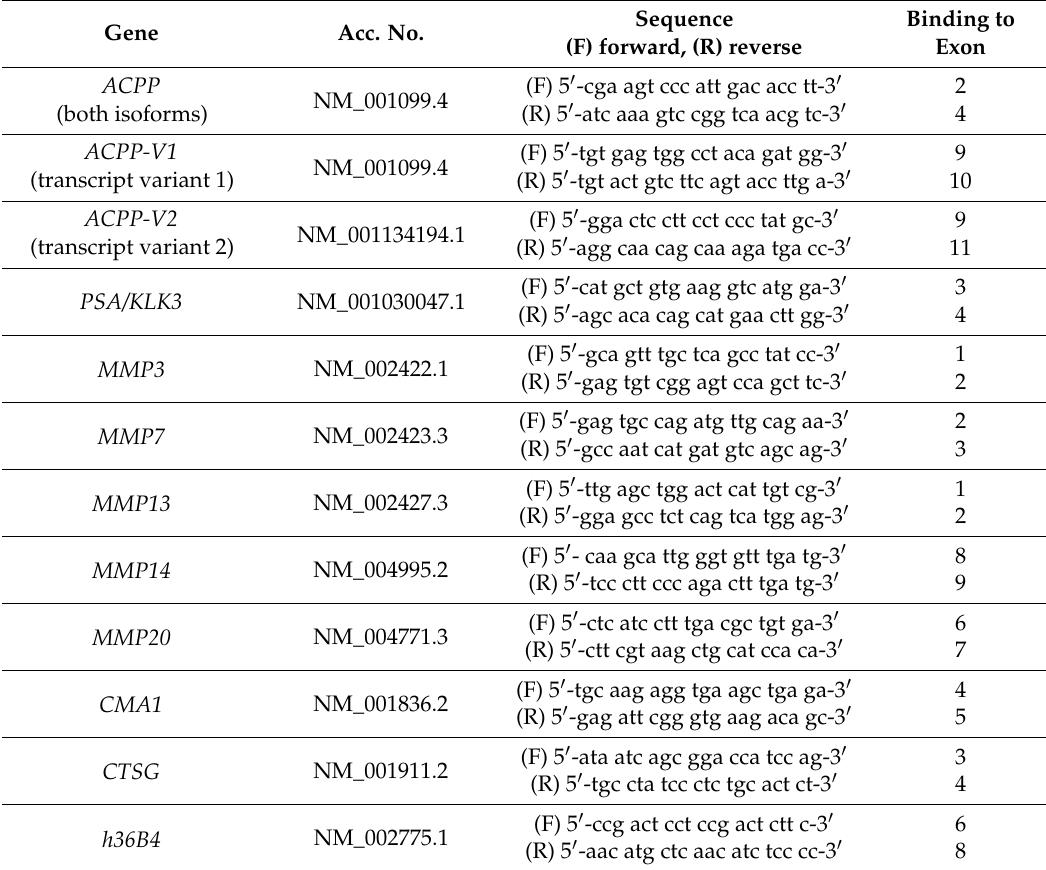
Table 3. Primer pairs used for qPCR analysis of the liquefaction cascade. KLK3 (PSA): kallikrein related peptidase 3; MMP: matrix metalloproteinase; CMA1: chymase 1; CTSG: cathepsin G; ACPP: prostatic